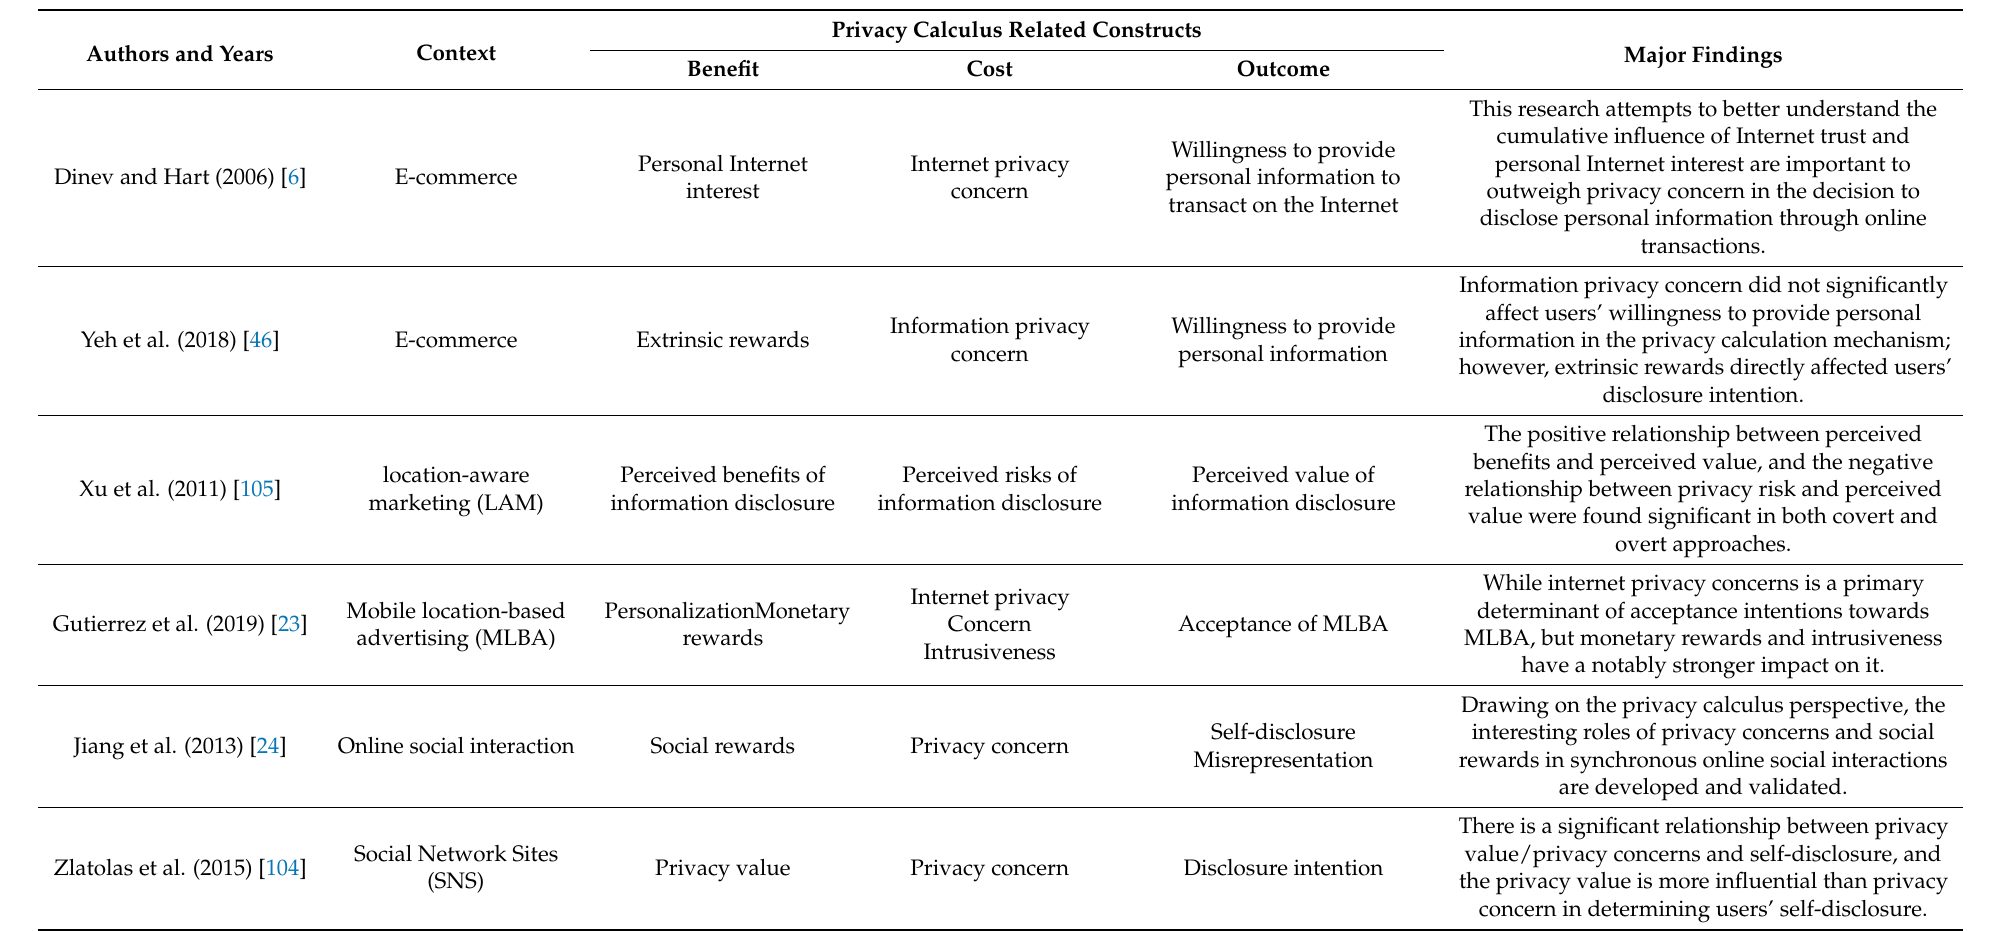
Table A1. Positivist IS Studies on Privacy